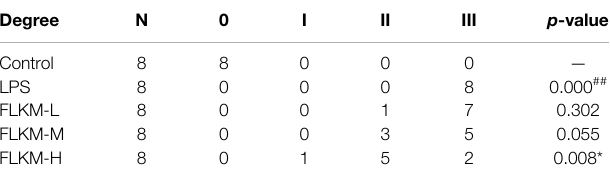
TABLE 3 | The degree of pathological change in rat lung tissues.